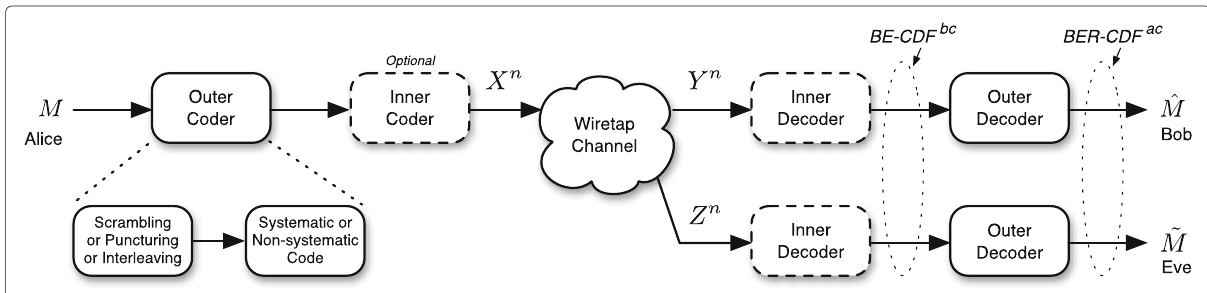
Fig. 1 Wiretap channel model assuming a concatenated coding scheme, where the outer code is for secrecy and the inner code is for reliability. Note that the inner code is marked as optional, and if it is removed, then this model reduces to the traditional wiretap channel model. The new metrics presented in this work are BE-CDF bc (where bc indicates beforecode ) and BER-CDF ac (where ac indicates aftercode